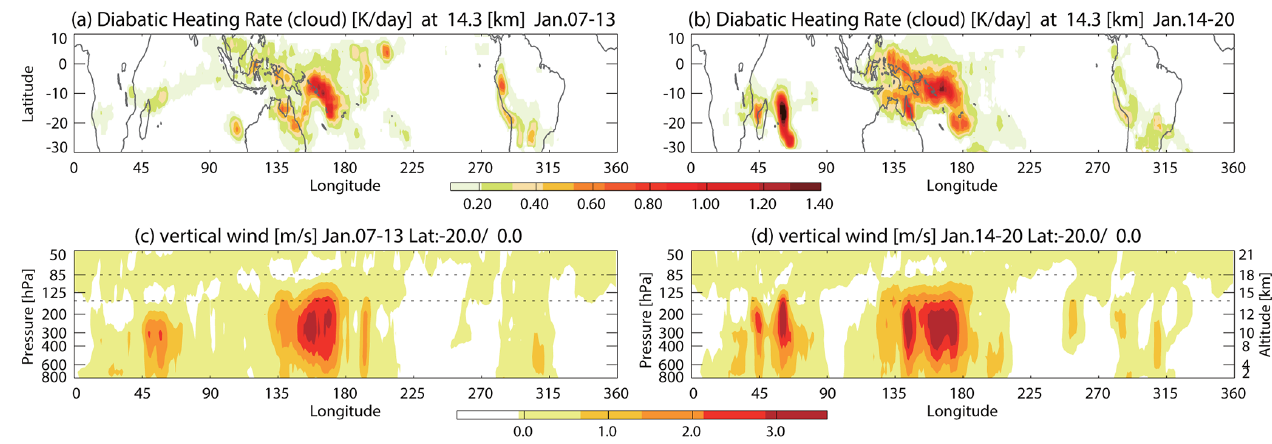
Figure 5. Maps of diabatic heating rate from cloud microphysics (Kday − 1 ) at 14.3km (a, b) averaged over 7–13 January (left, a ) and 14– 20 January (right, b ). The panels (c, d) show longitude–pressure sections of vertical wind (ms − 1 ) averaged between 20 ◦ S and equator on 7–13 and 14–20 January, respectively. The vertical wind data are smoothed by applying a weighting function of five-degree-longitude width. The horizontal dotted lines in (c, d) show the 85hPa and 150hPa pressure levels for